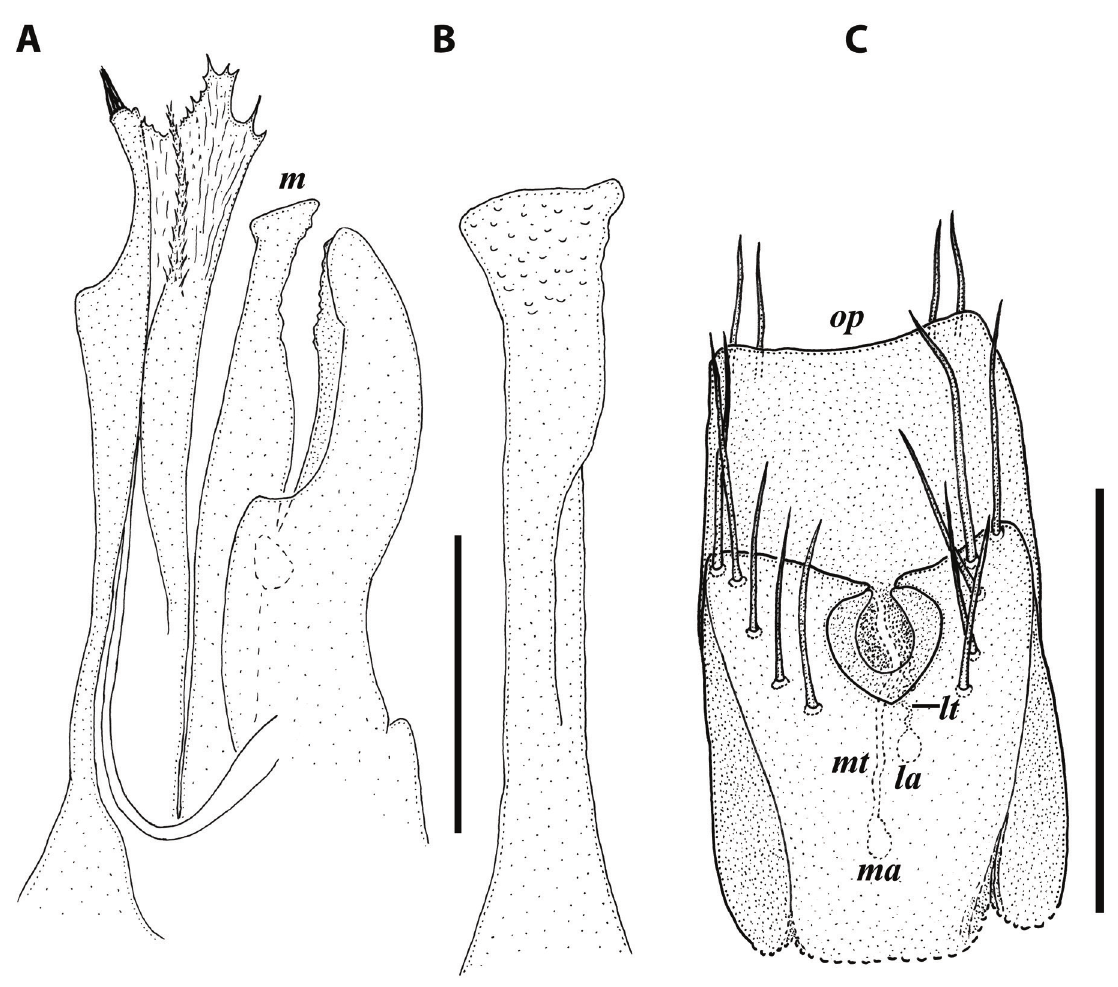
Fig. 7. Stygiiulus montellensis (Verhoeff, 1930) comb. nov., ♂ from Grotta [cave] Crede-a (NHMD). A . Right gonopods, mesal view. B . Right mesomere, oral view. C . Left vulva, caudal, slightly mesal view. Abbreviations: la = lateral ampulla; lt = lateral tube; m = mesomere; ma = median ampulla; mt = median tube; op = operculum. Scale bars: A –B = 0.2 mm; C = 0.3